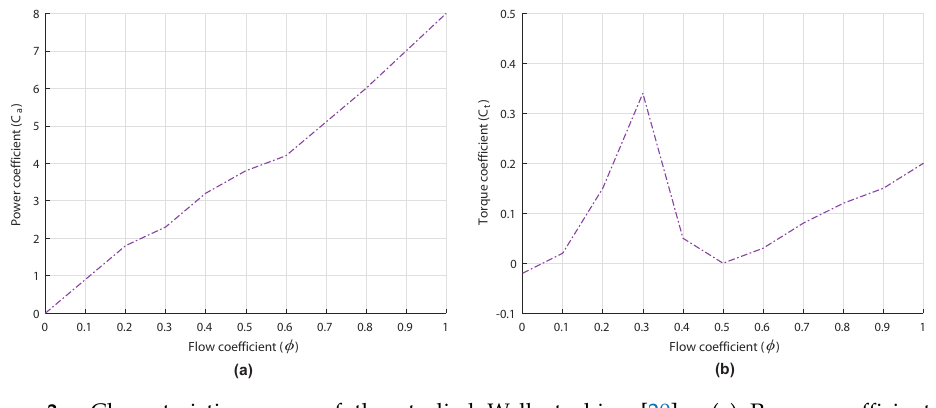
Figure 3. Characteristic curves of the studied Wells turbine [20]. ( a ) Power coefficient vs. flow coefficient. ( b ) Torque coefficient vs. flow